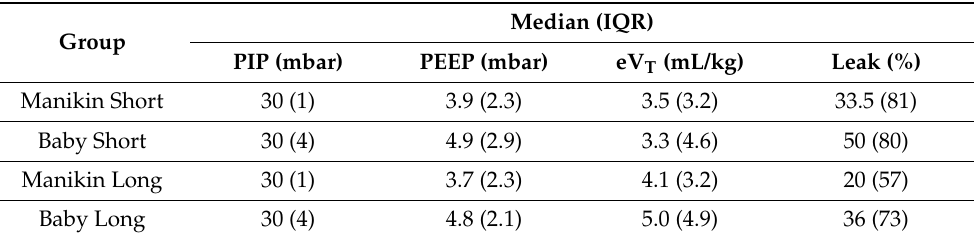
Table 1. Median (interquartile range) ventilatory parameters for the four groups.